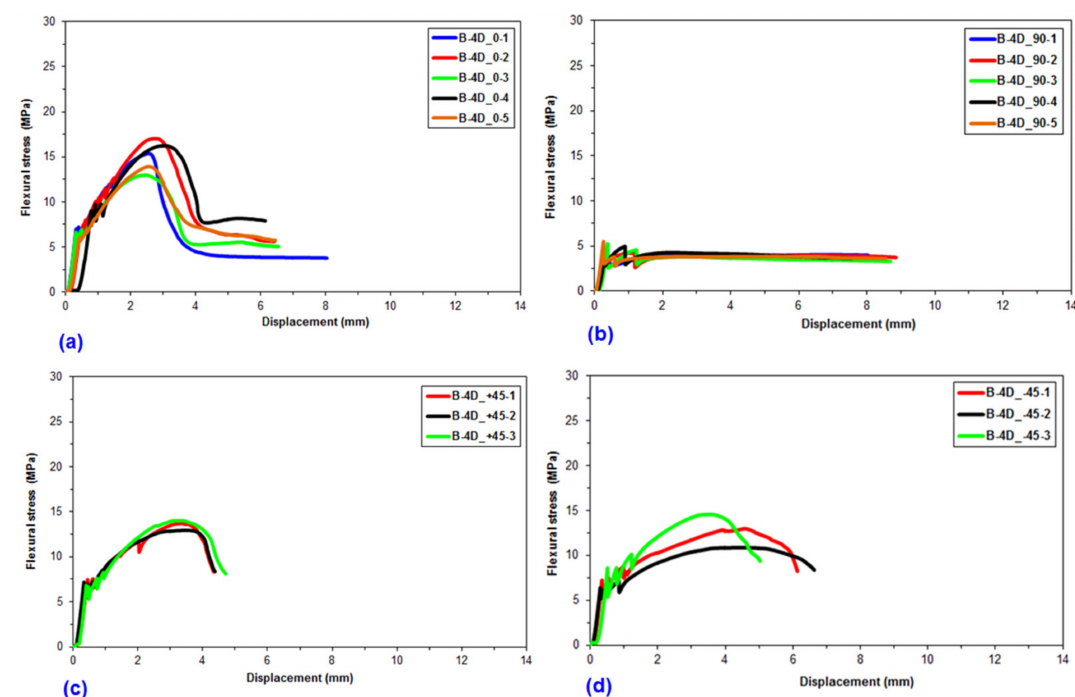
Figure 7. Stress-displacement graph of multiaxis 3D basalt TOW concretes in the four-point flexure test. ( a ) B-4D at 0 ◦ flexure test; ( b ) B-4D at 90 ◦ flexure test; ( c ) B-4D at +45 ◦ direction flexure test; ( d ) B-4D at − 45 ◦ direction flexure test.